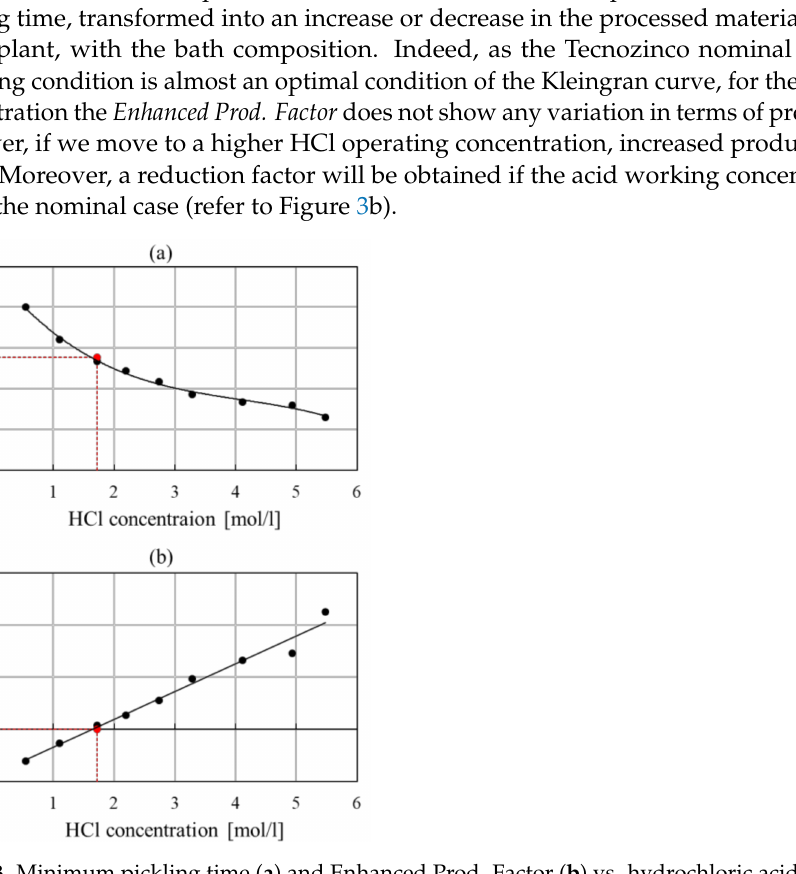
Figure 3. Minimum pickling time ( a ) and Enhanced Prod. Factor ( b ) vs. hydrochloric acid concentra- tion. Red dot is the reference condition of the Tecnozinco pickling